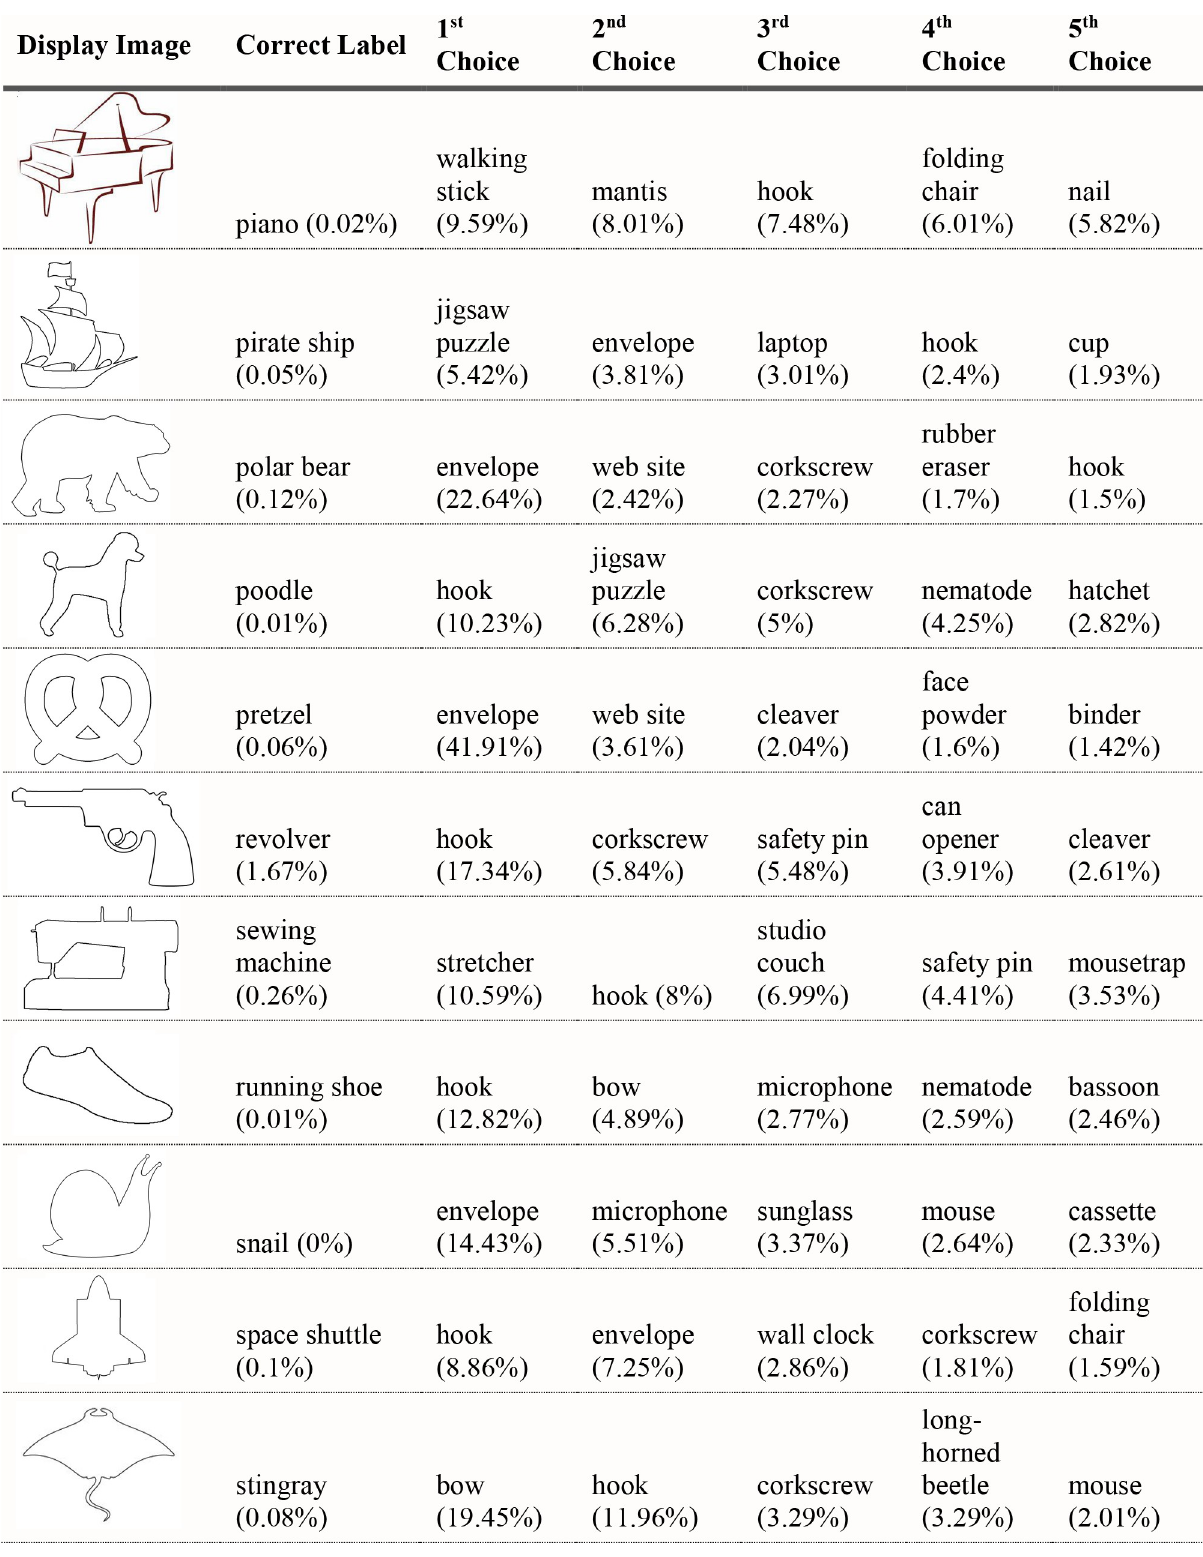
Fig 16. VGG-19 classifications for object outlines Part 3.